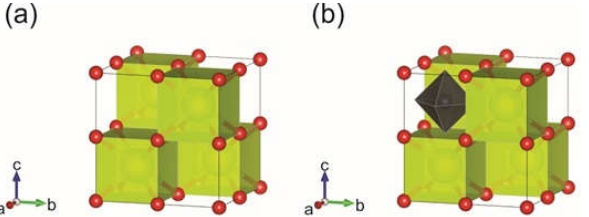
Figure 7. The fluorite structure of ceria ( a ) and the fluorite structure of ceria containing the empty octahedral void (grey) ( b ). The light green and red balls represent Ce and O atoms, respectively. For Ce 1-2 x Sm 2 x O 2- x ( x = 0.05, 0.10, 0.15) solid solutions, the cation sublattice occupation is partial. Nevertheless, the calculation of the properties of this material by the ab initio